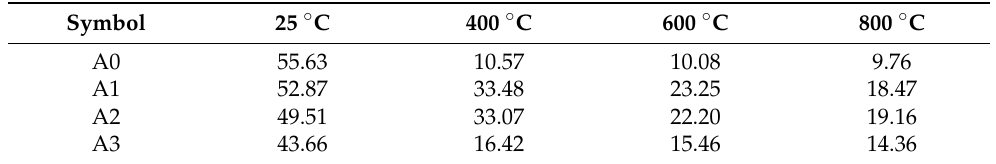
Table 4. Compressive strength of 28 d specimens with M:P of 2:1 after high temperature overheating (unit: